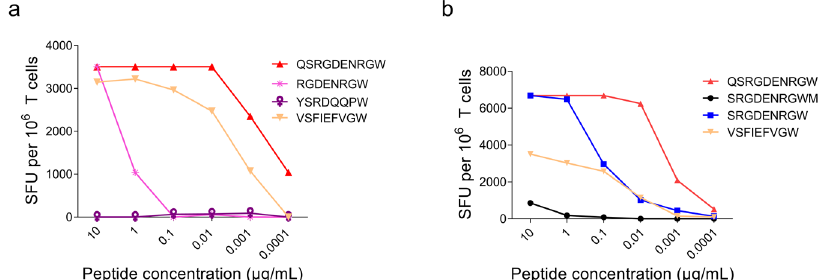
Fig. 6 Mapping the HLA-B*57:01 restricted EBNA3C epitope. a Identi fi cation of the T cell epitope from the EBNA3C 1 – 300 amino acid minigene. b Mapping the minimal QSRGDENRGW epitope. The peptides were screened in an IFN γ ELISpot assay by pulsing K562-B*57:01 with peptides and incubating with T LCL line of donor 1. The data are spot forming units (SFUs) per million cells.